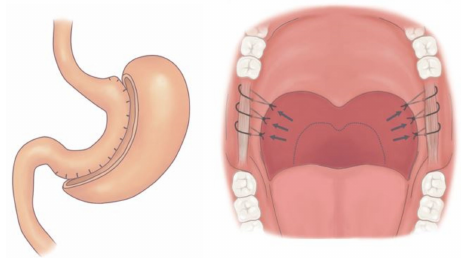
Figure 1. Combined airway and bariatric surgery (CABS) to solve obesity and obstructive sleep apnea at